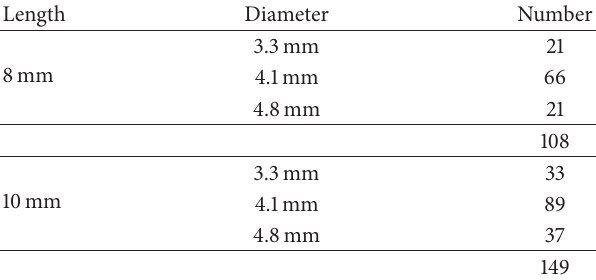
Table 1: Implant distribution by diameter, length, and